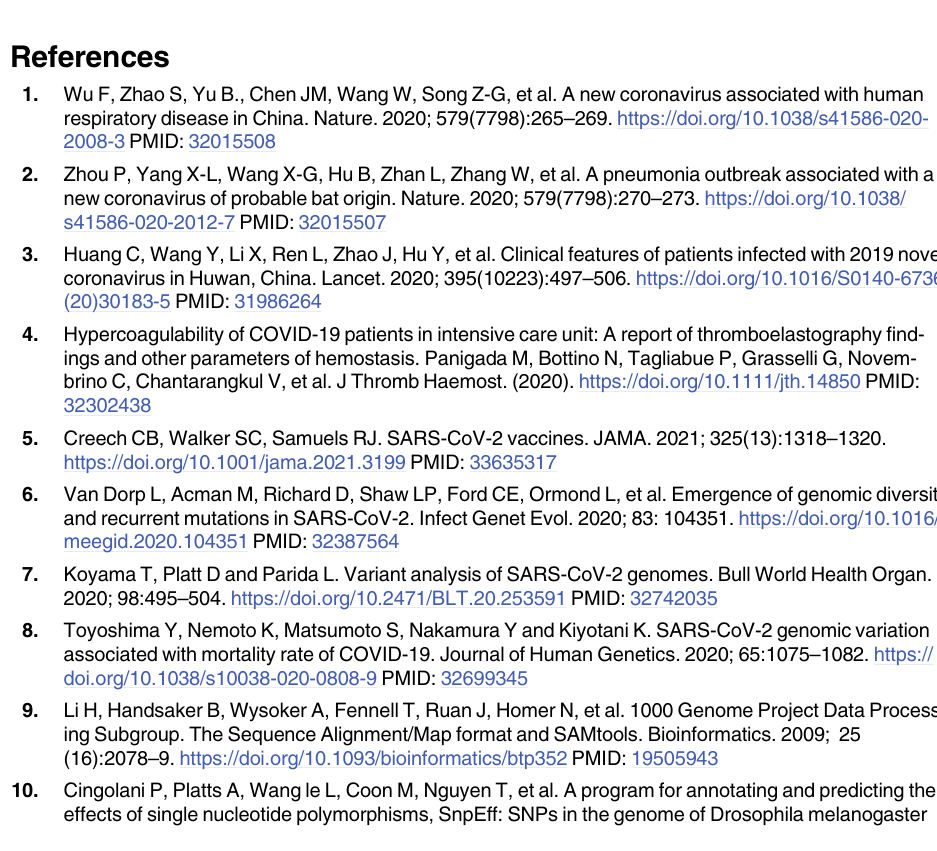
S1 Table. List of all analyzed sequences with collection dates and presence of most fre- quents variants. S2 Table. Haplotype identified starting from the 53 most frequent variants. S3 Table. Frequency of each variant in all countries. S4 Table. List of all identified